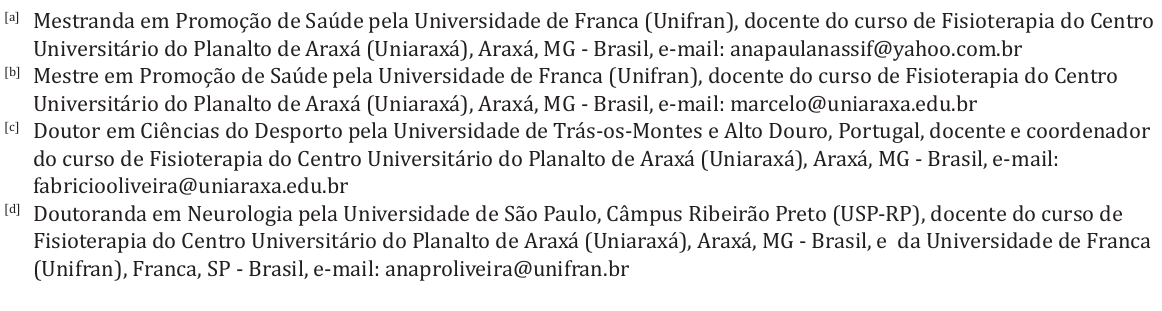
Introdução : O declínio da capacidade cognitiva (DCC) decorre dos processos fisiológicos do envelhecimento normal ou de um estágio de transição para as demências. A demência é uma síndrome clínica que se relaciona às perdas neuronais e danos à estrutura cerebral, levando o indivíduo a apresentar alterações cognitivas e funcio- nais que interferem nas atividades diárias. Objetivo : Analisar o declínio da cognição e o seu impacto nas habili- dades funcionais em idosos institucionalizados e não institucionalizados. Materiais e métodos : Avaliaram-se dois grupos, de ambos os sexos e idade entre 55 a 86 anos, divididos em indivíduos institucionalizados e não institucionalizados. No grupo não institucionalizado foram avaliados 31 idosos; no grupo dos indivíduos insti- tucionalizados, 22. Primeiro houve a caracterização do idoso, seguida pela aplicação do Mini Exame de